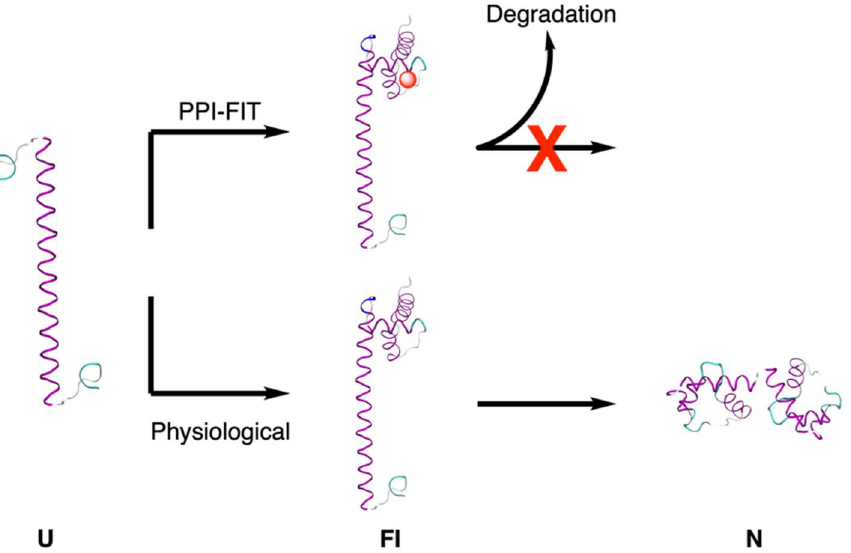
Figure 3. Schematic representation of the PPI-FIT approach to protein regulation. U = unfolded; FI = folding intermediate; N = native. The red sphere represents the drug molecule.